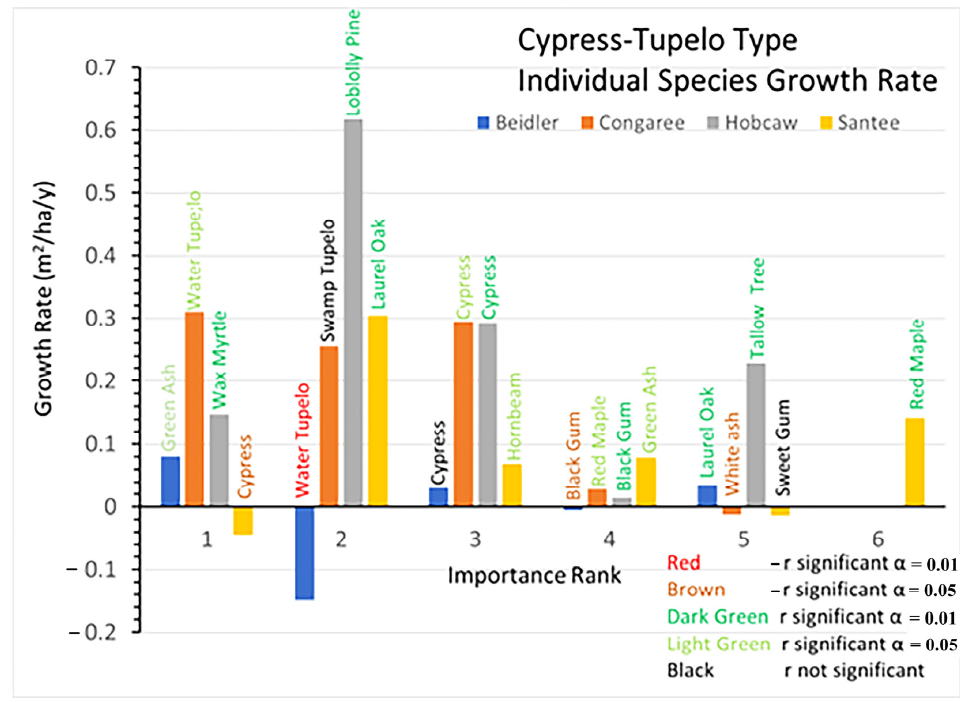
Figure 6. Distribution of basal area growth of species, by importance factor (1 means the most important, while 6 means the least important), for each study site of the cypress-tupelo vegetation type.